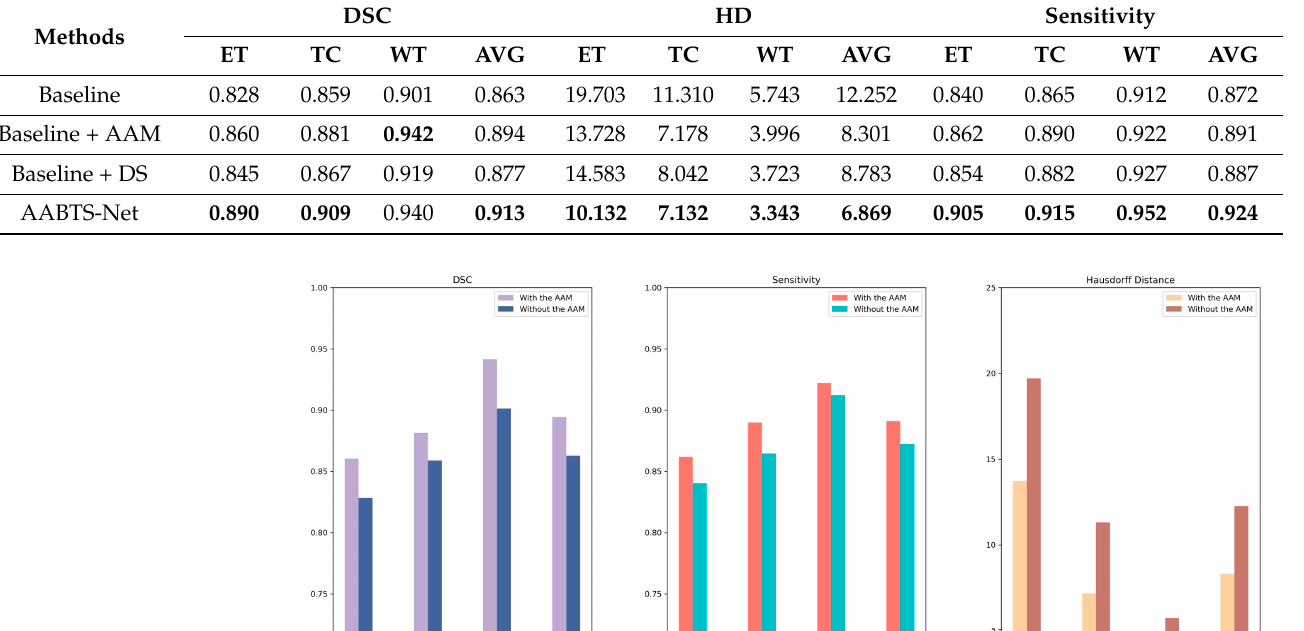
Table 5. The ablation studies of the different methods on the BraTS 2021 training dataset (1251 cases). All experiments were performed via 5-fold cross-validation on the training cases (no external data were used). (Bold font indicates best results.)